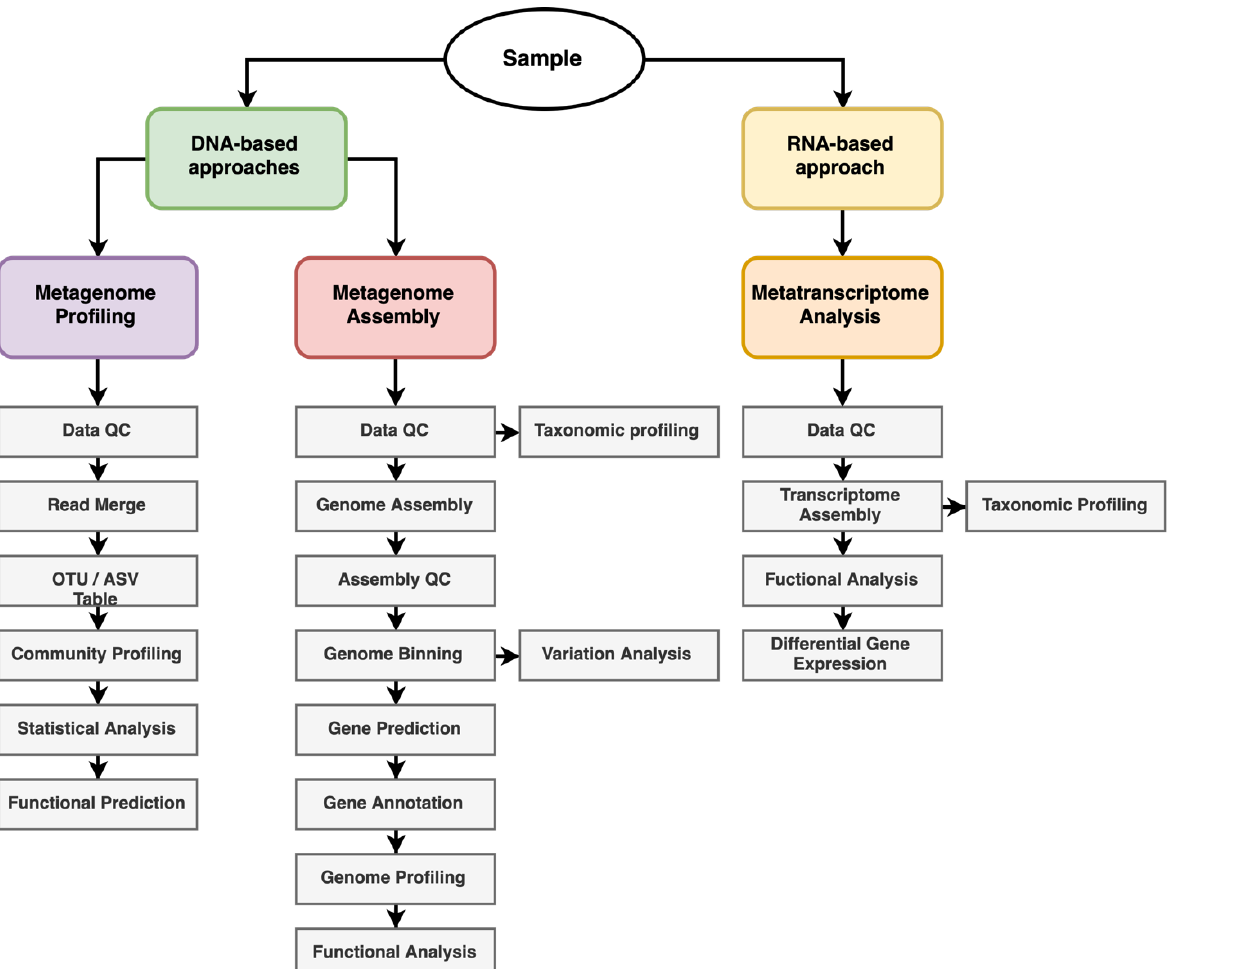
Figure 2. Overview of metagenome and metatranscriptome analysis workflow.